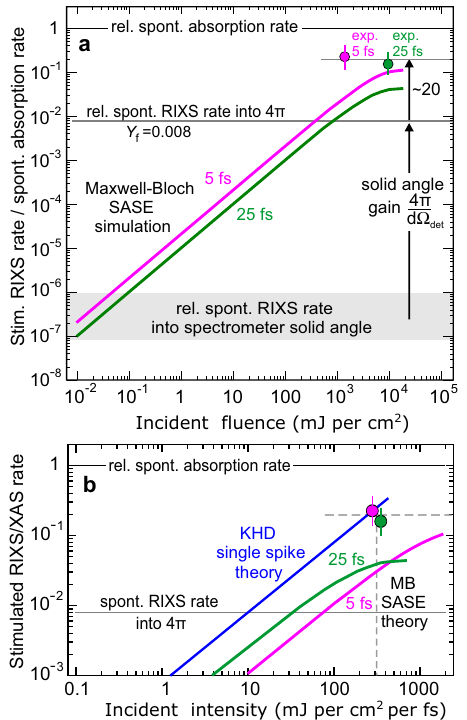
Fig. 5 Experimental and simulated dependence of stimulated Resonant Inelastic X-ray Scattering (RIXS) ampli fi cation on X-ray fl uence and X-ray intensity. Here, rel. stands for relative, spont. stands for spontaneous, stim. stands for stimulated, XAS stands for X-ray absorption spectrum, Y f is the fl uorescence yield and Ω det is the solid angle of acceptance of the spectrometer. a Dependence of stimulated RIXS ampli fi cation on fl uence and pulse duration. The magenta and green circles are the experimentally determined stimulated RIXS intensities for 5 fs and 25 fs pulses relative to the spontaneous absorption rate. The error bars estimate the standard error in the absence of nonlinear effects. Also indicated as a horizontal line is the spontaneous RIXS rate emitted into 4 π , i.e. the fl uorescence yield Y f = 8 × 10 − 3 7 . The correspondingly colored curves represent RIXS rates for L 3 excitation of Co atoms, relative to the spontaneous absorption rate, calculated by use of a statistical Self- Ampli fi ed Spontaneous Emission (SASE) pulse description combined with a three level Maxwell-Bloch (MB) theory. The gray shaded region at the bottom indicates the fraction of the spontaneous RIXS signal typically seen by a detector with an angular acceptance of order 10 − 5 − 10 − 4 . Vertical arrows indicate the two contributions to the observed stimulated RIXS relative to the absorbed rate. b The data in a are plotted as a function of incident intensity and comparison with the Kramers-Heisenberg-Dirac (KHD, blue) and MB (magenta and green) theories.